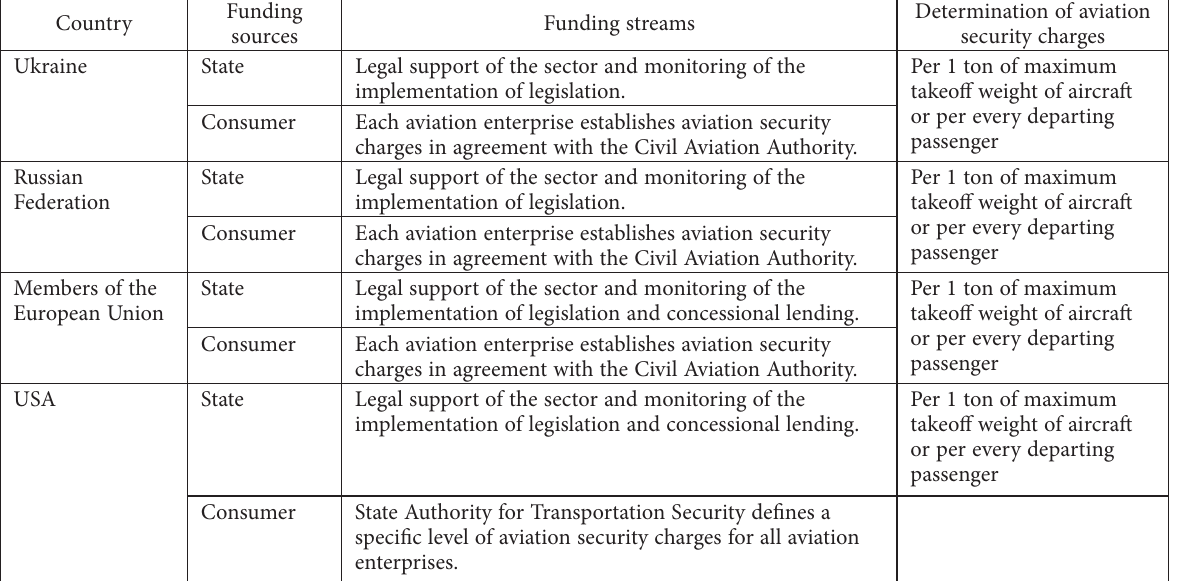
Table. Funding sources and streams